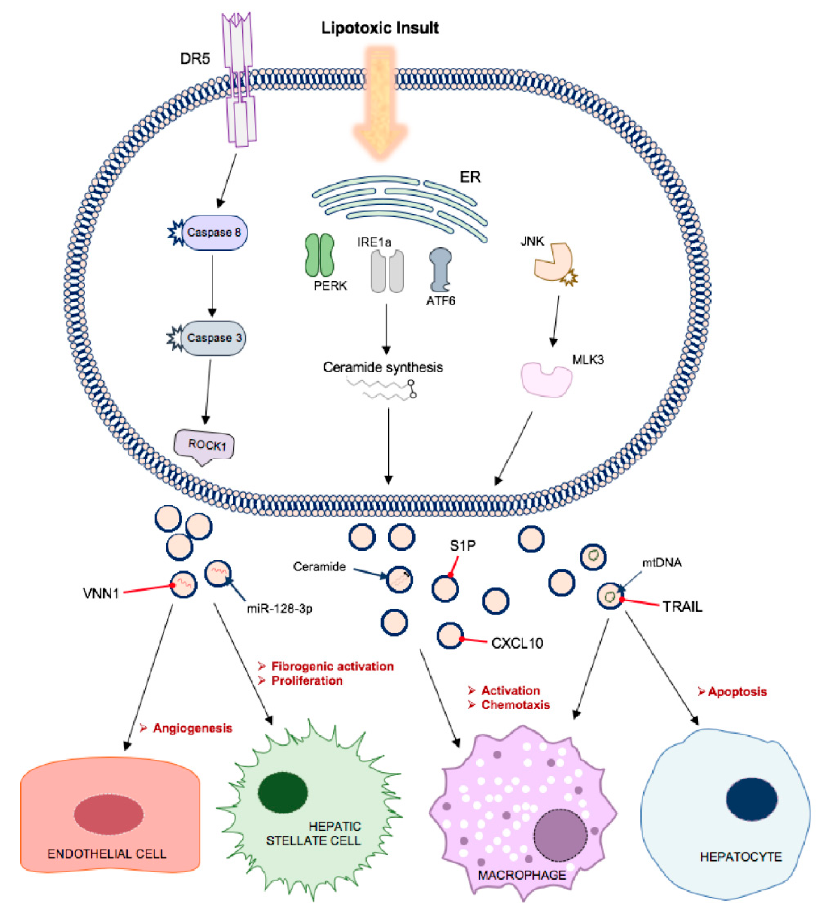
Figure 4. Lipotoxic hepatocytes release increased numbers of small EVs containing specific cargo that contribute to disease processes in non-alcoholic fatty liver disease. Multiple signalling pathways, including via ER stress sensors, c-Jun N-terminal kinase (JNK) and caspase activation, promote the release of EVs with cargo that promote endothelial cell migration and angiogenesis, transdifferentiation of hepatic stellate cells to a profibrogenic phenotype, macrophage activation and chemotaxis and apoptosis of neighbouring hepatocytes.